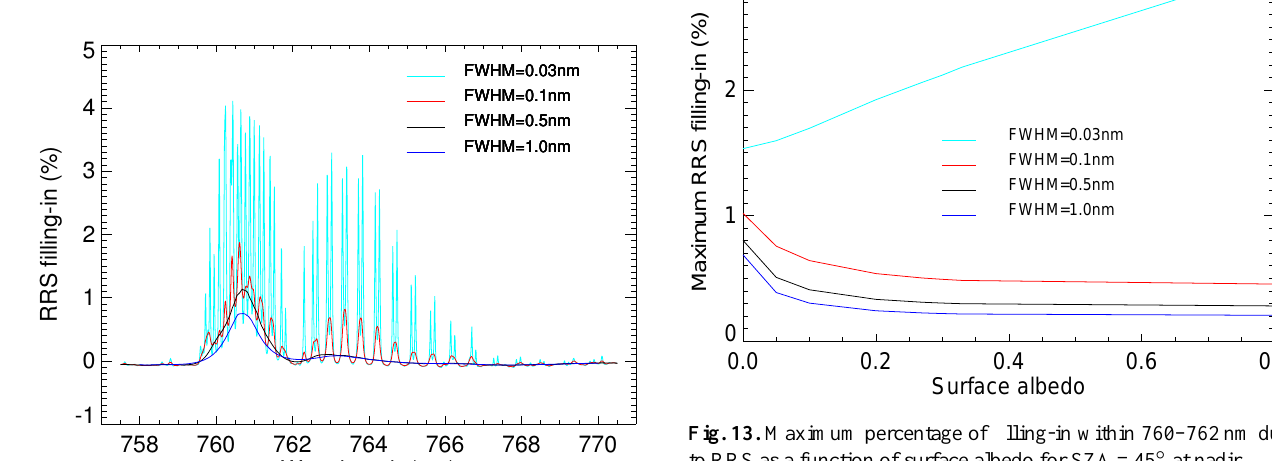
Fig. 12. Similar to Fig. 4 but computed with the higher spectral sampling solar irradiance (0.001 nm). 0.0